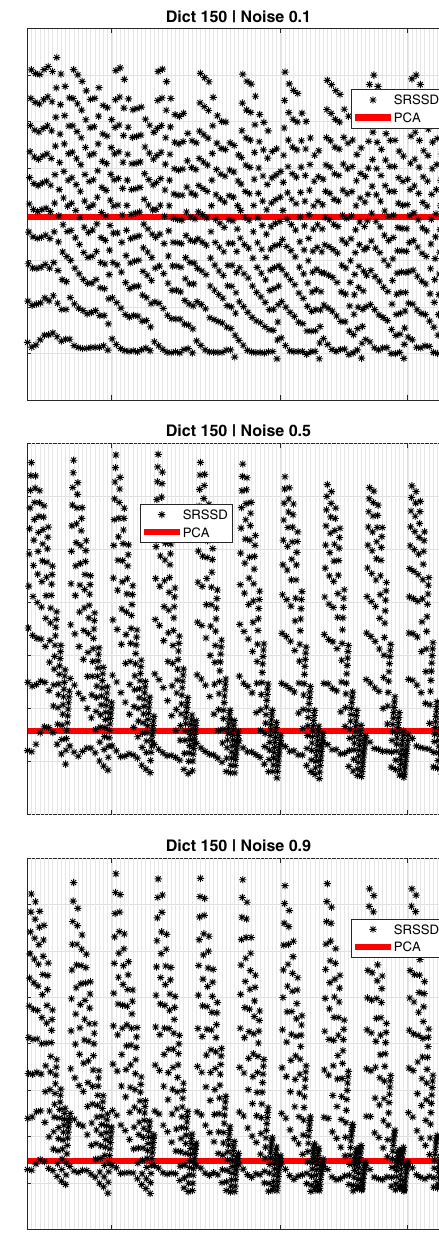
Figure 7. Comparison between the reconstruction (RMS) error of SRSSD (blue dots) and PCA (red line) across various levels of noise. Each figure shows 100 dictionaries found during the learning step. We remind that each reconstruction relies on 2 kinds of sparsity: atom structured sparsity (varied during the learning phase) and coefficient sparsity (which is varied here); see the Methods section. Here, each of the 100 dictionaries (with its fixed atom sparsity) is tested with 10 different values of the coefficient sparsity parameter. Hence, for each figure, each of the 1000 asterisks corresponds to a unique combination of dictionary and coefficient sparsity. The reconstruction error for all the asterisks that appear under the red line is better than